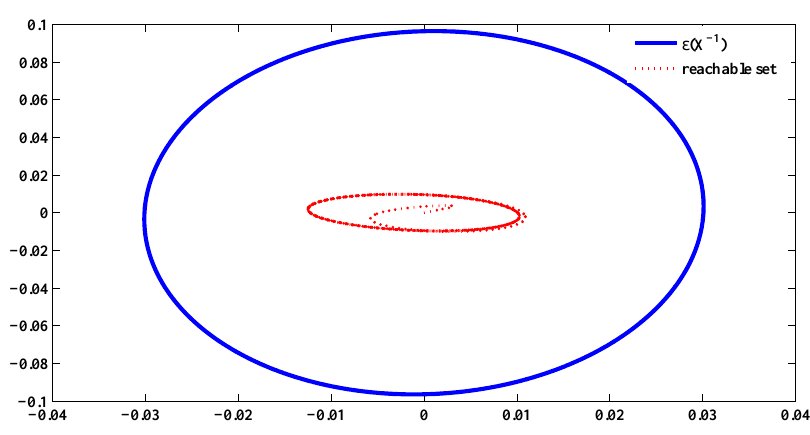
Figure 3. Bounding ellipsoid and reachable set of TS fuzzy system with actuator fault.